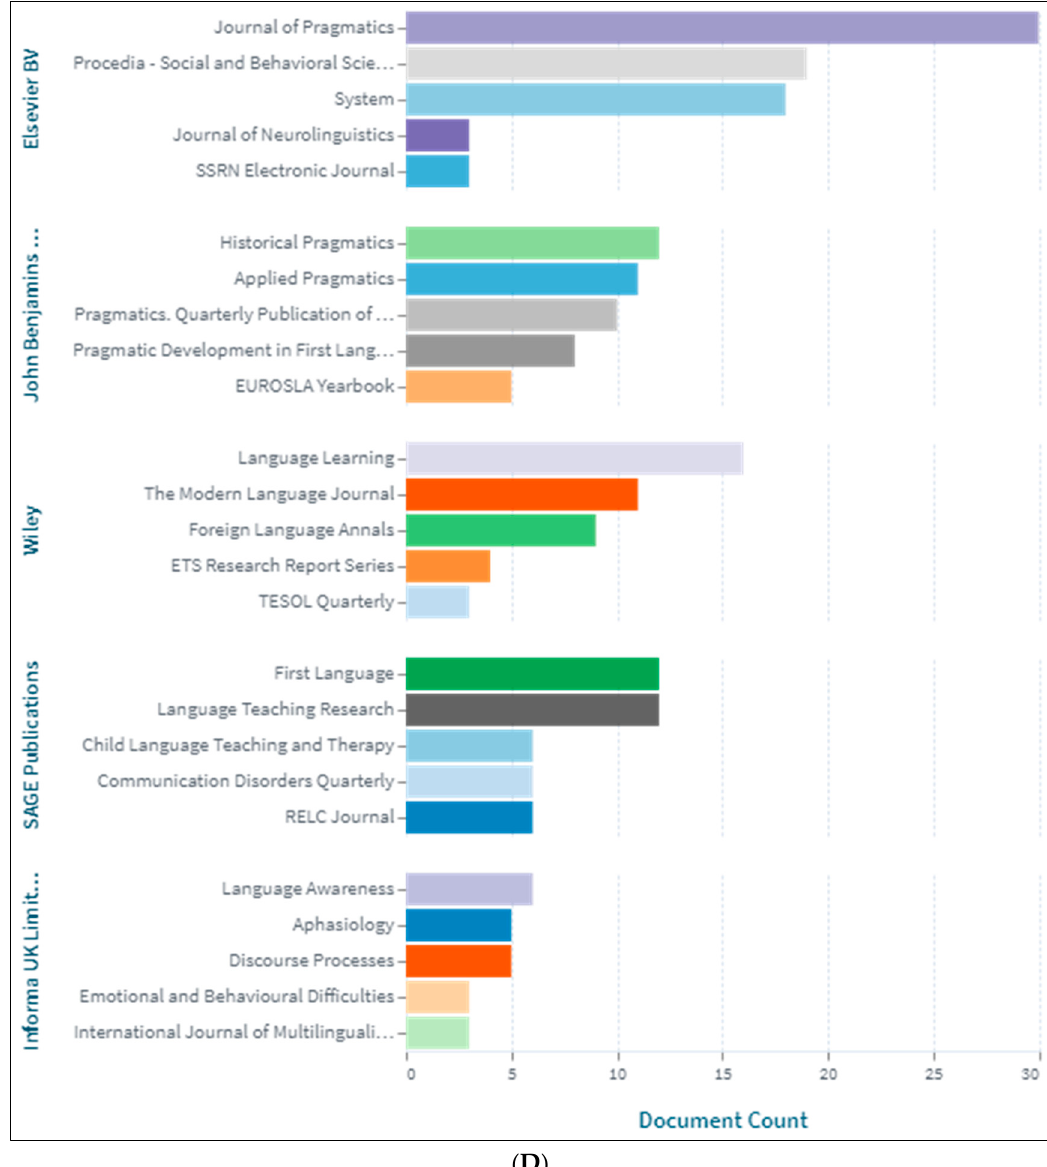
Figure 4. Pragmatic language development knowledge production size by journal: ( A ) Scopus; ( B ) WOS; ( C ) Lens; ( D ) Lens.